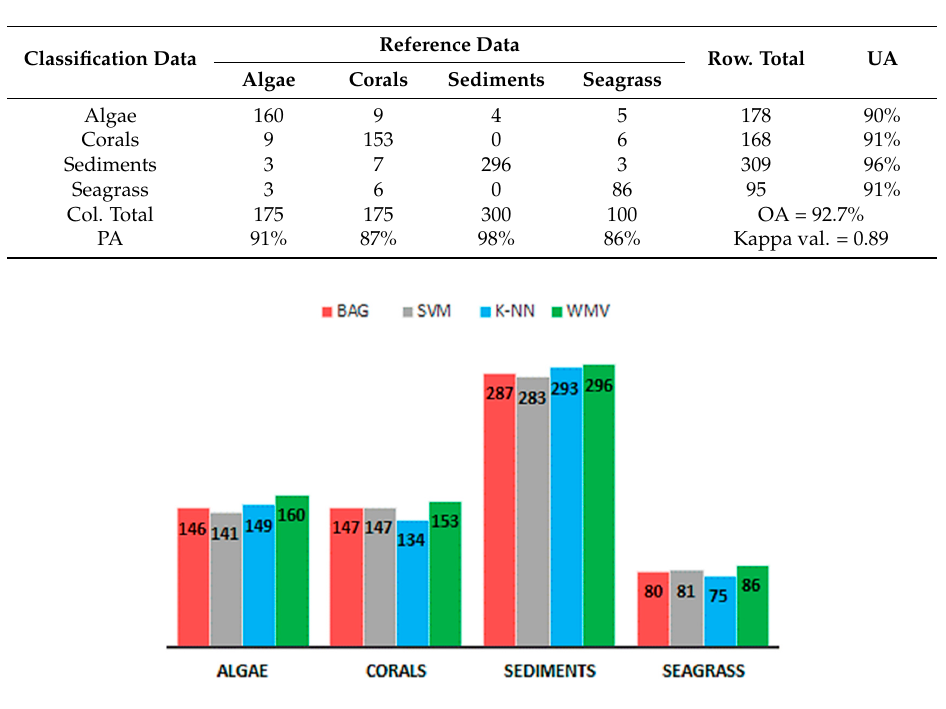
Figure 10. The number of the correct species classified by each classifier for benthic cover mapping. Table 3. The OA and Kappa results of all methods for benthic habitats mapping for the Shiraho area.